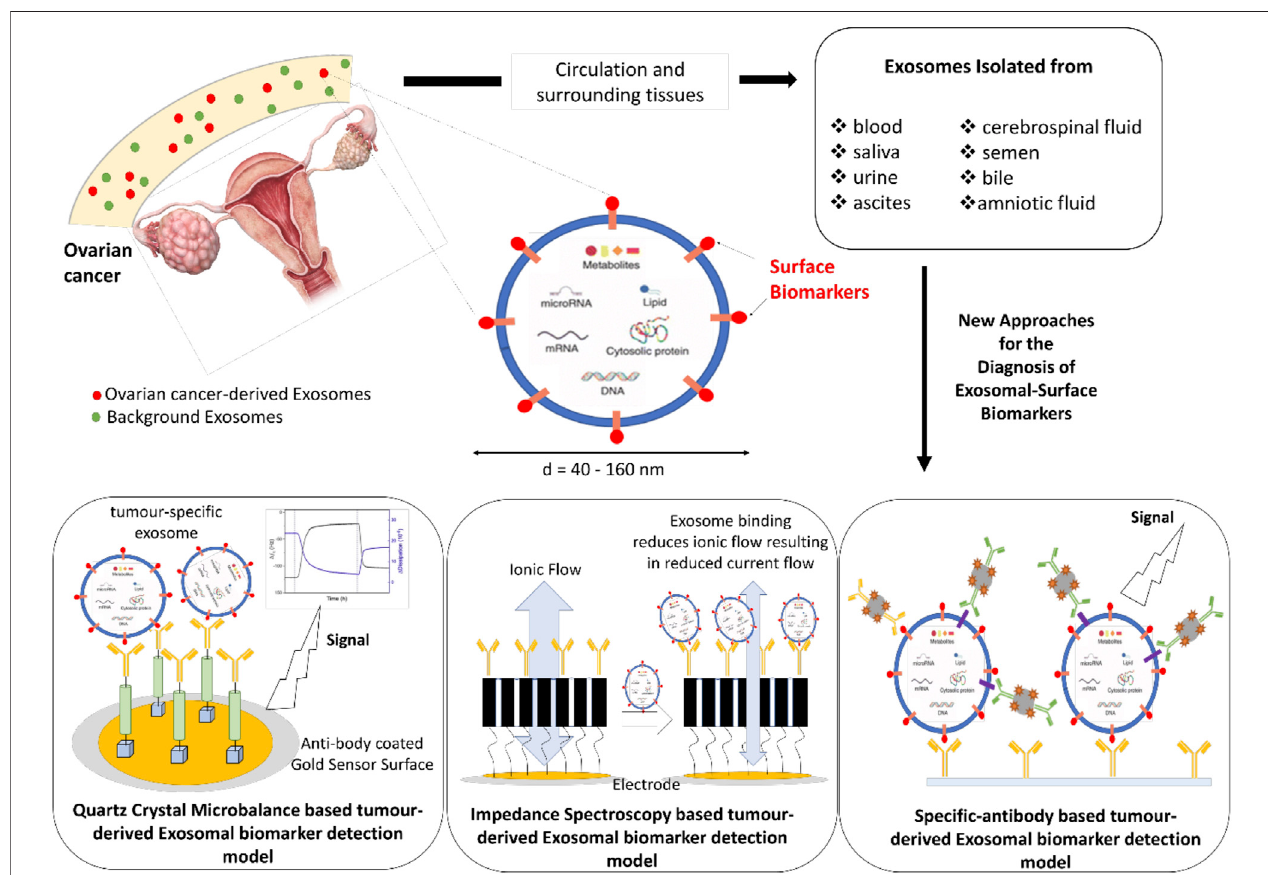
FIGURE 1 | Schematic representation of new diagnostic approaches for the detection of Exosomal-Surface Biomarkers.